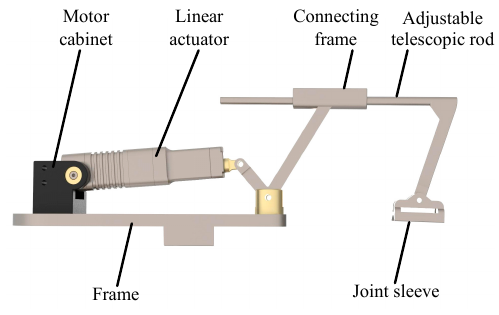
Figure 4. The thumb mechanism.